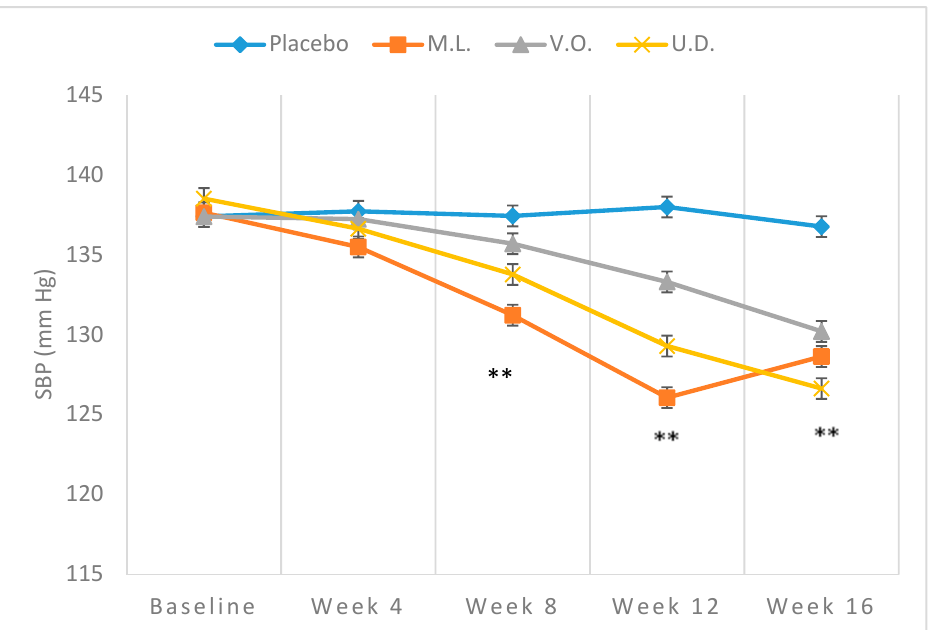
Figure 1. Means ± SD of SBP, measured over 16-week intake of 300 mL/day of M. longifolia (M.L.), V.odorata (V.O.) and U. dioica (U.D.) in mild hypertensive subjects. ** p < 0.01 (M.L. and U.D. compared to Placebo at week 8 and M.L., V.O., and U.D. compared to Placebo at weeks 12 and 16).